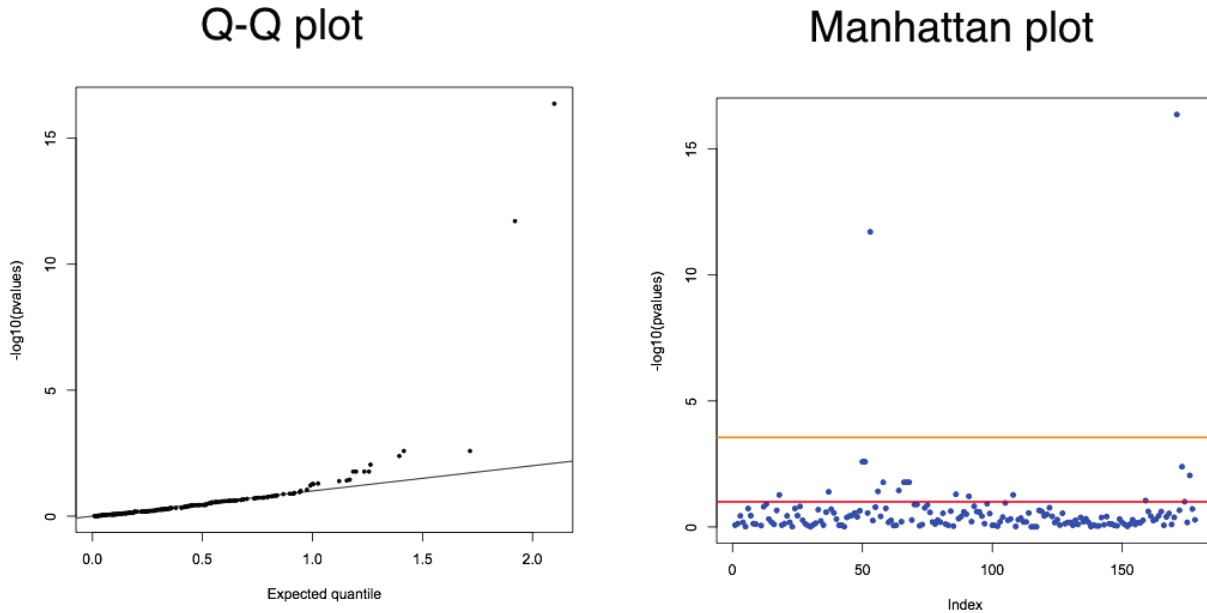
Figure 8. LFMM results showing associated marker loci with sex differentiation in date palm cultivars